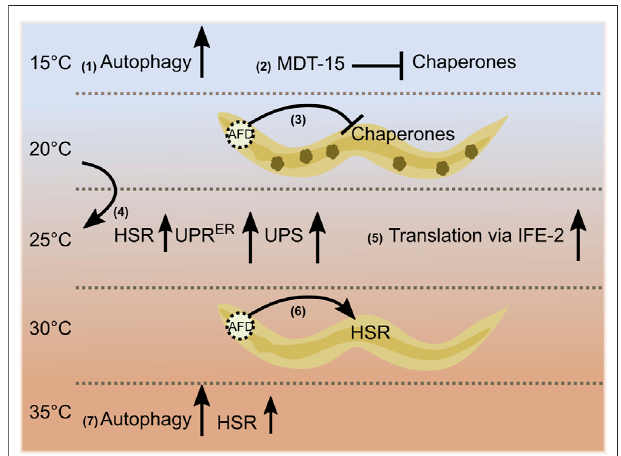
FIGURE 1 | Temperature-dependent regulation of proteostasis. Autophagy and chaperone levels are affected at low temperatures via fatty acid signaling (1), (2). A wild-type thermosensory circuit attenuates protein folding during chronic stress; small dark green structures inside the worm indicate protein aggregates (3). A 1-day transfer of late larval staged C. elegans from 20 to 25 ° C increases the heat shock response [HSR (mildly, small arrow)], the unfolded protein response in the endoplasmic reticulum (UPR ER ), and the activity of the ubiquitin/proteasome-system (UPS) in the intestine (4). The translational ef fi ciency of selective mRNAs ( msh-4/him-14 , msh-5 ) increases at 25 ° C via an eIF4E family protein, IFE-2 (5). AFD thermosensory neuron cells non-autonomously regulate the heat shock response [acute heat shock (HS) of 30 ° C for 15 min] (6). Hormetic heat shock of 1 h at 36 ° C induces autophagy and selective HSR